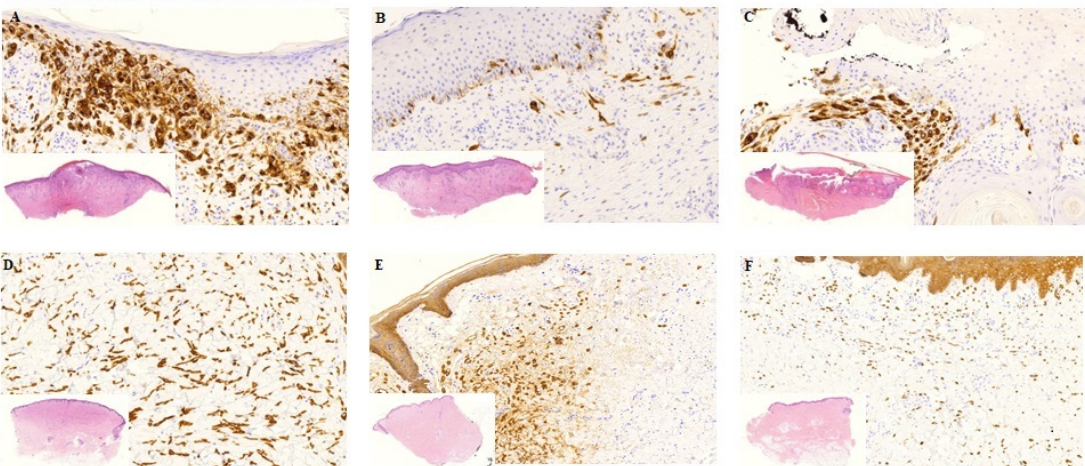
Figure 2. Histology from biopsies before and 7 days after treatment. Biopsies before and one week after treatment. ( A – C ) Patient nr. 5 with MM. A: Pre-treatment biopsy: Extensive tumour infiltration, mild fibrosis, moderate lymphocytic inflammation, no necrosis. The tumour cells show di ff use MelanA positivity. ( B ) Day 7. Post-treatment with Ca-EP: Partly ulcerated skin, moderate tumour infiltration and fibrosis, mild inflammation, no necrosis. Only scattered MelanA positive tumour cells. ( C ) Day 7. Post treatment with bleomycin-based ECT: Partly fragmented, ulcerated skin with pseudoepitheliomatous hyperplasia of the epidermis, moderate fibrosis and inflammation, no necrosis. Focal MM nests with MelanA positivity. ( D – F ) Patient nr. 2 with breast cancer. ( D ) Pre-treatment biopsy: Extensive breast cancer infiltration without fibrosis, inflammation and necrosis. The tumour cells are CKAE1 / AE3 positive. ( E ) Day 7. Post-treatment with Ca-EP: Focal tumour infiltration, very mild inflammation no fibrosis or necrosis. ( F ) Day 7. Post treatment with bleomycin-based ECT: Dispersed tumour cells with CKAE1 / AE3 positivity, mild inflammation, no fibrosis or necrosis. MM: malignant melanoma, CK: cytokeratin. Histological photos: digital scanning with magnification approximately 5–20 ×